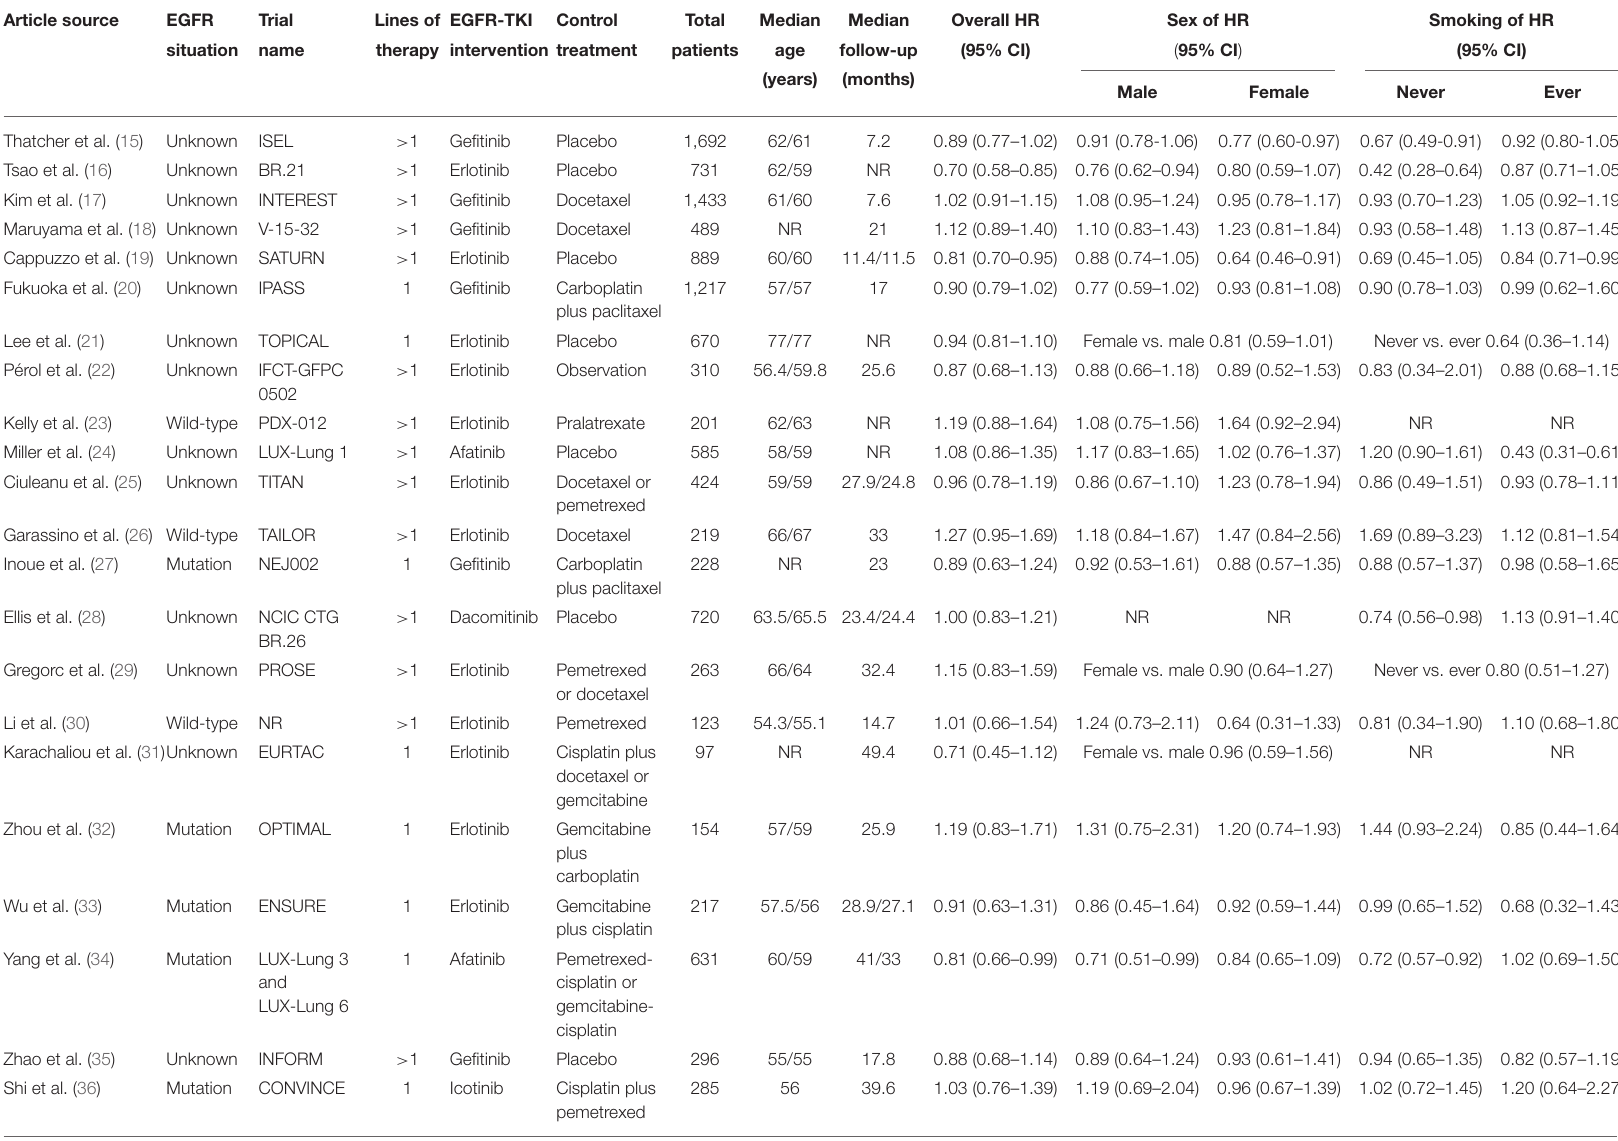
TABLE 1 | Main characteristics and results of the 22 studies included in the